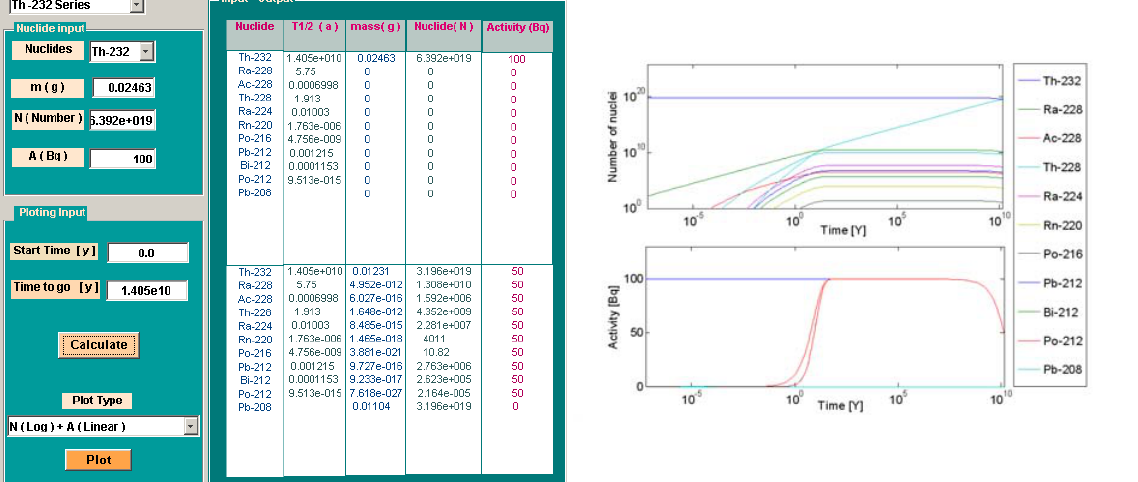
Fig. 4 Example of operation for the 232 Th decay chain with initial activity 100 Bq. Decay time is the half-life of 232